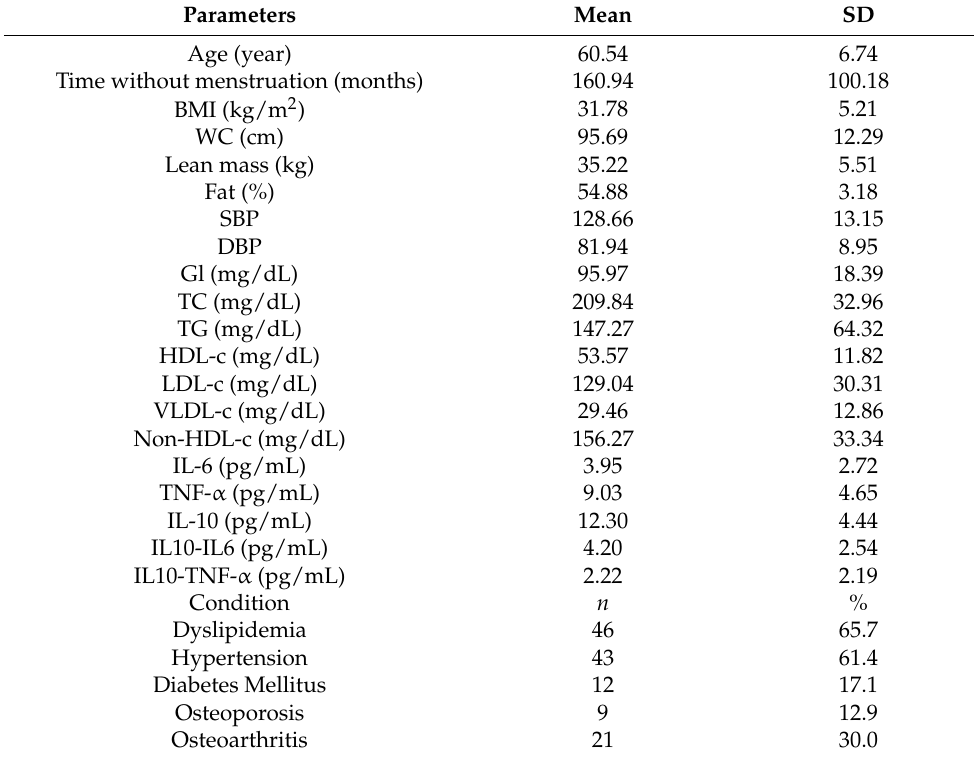
Table 1. Descriptive statistics of the variables that characterize the sample ( n = 70). Parameters